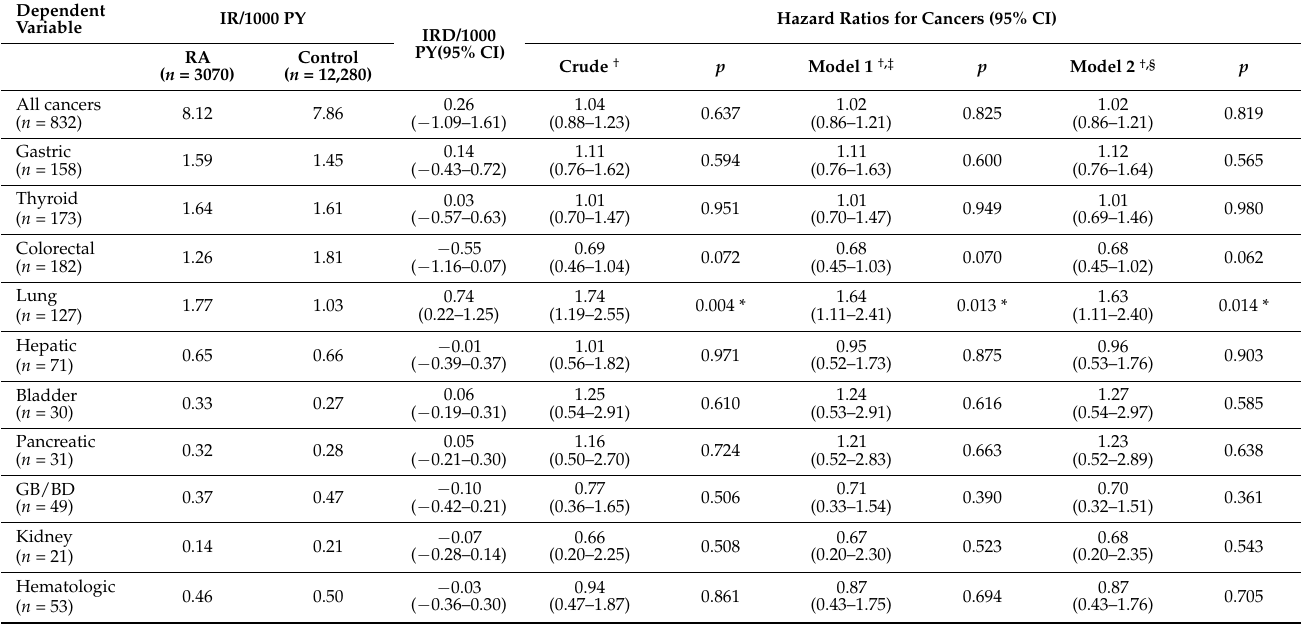
Table 2. Crude and adjusted hazard ratios of RA for various cancers.